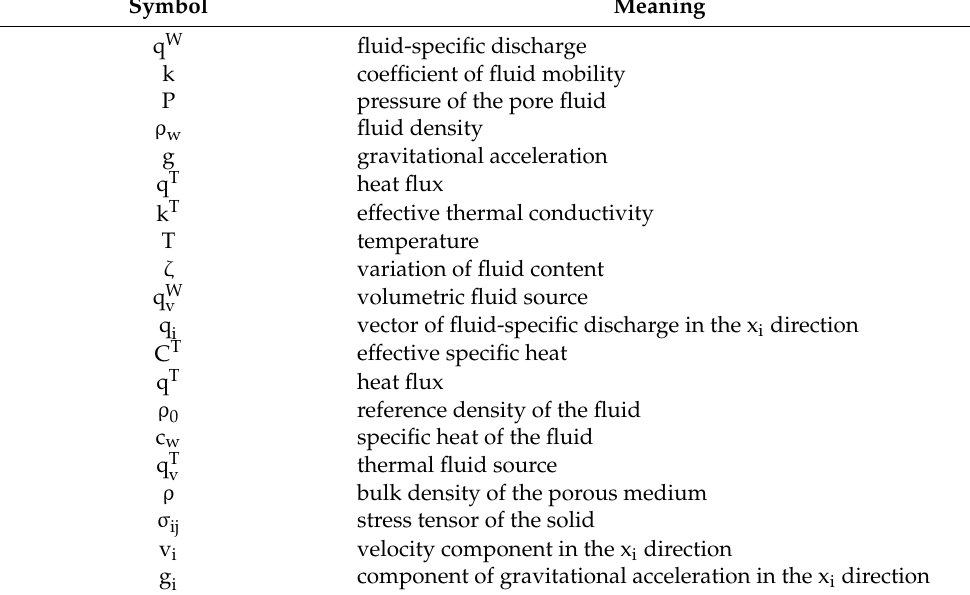
Table 1. Mathematical symbols and scientific meanings in